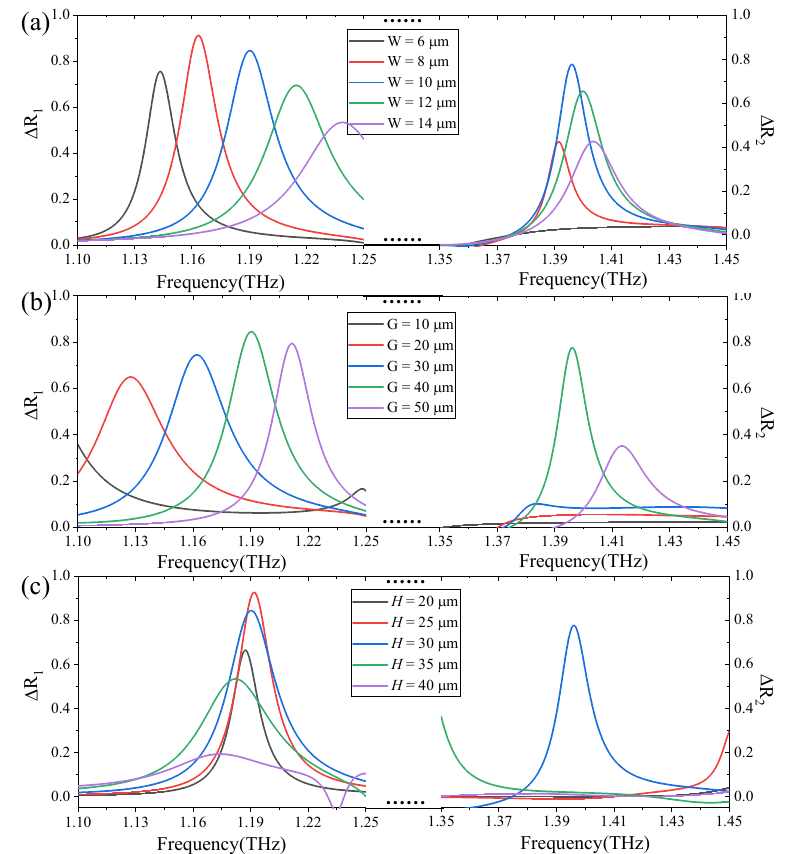
Figure 3. An illustration of the influence of the line width of the aluminum pattern, the opening gap of the aluminum pattern and the height of the polymide on ΔR 1 and ΔR 2 . ( a ) Simulation results of ΔR 1 and ΔR 2 under different line width of the aluminum pattern. ( b ) Simulation results of ΔR 1 and ΔR 2 under different the opening gap of the aluminum pattern. ( c ) Simulation results of ΔR 1 and ΔR 2 under different the height of the polymide.